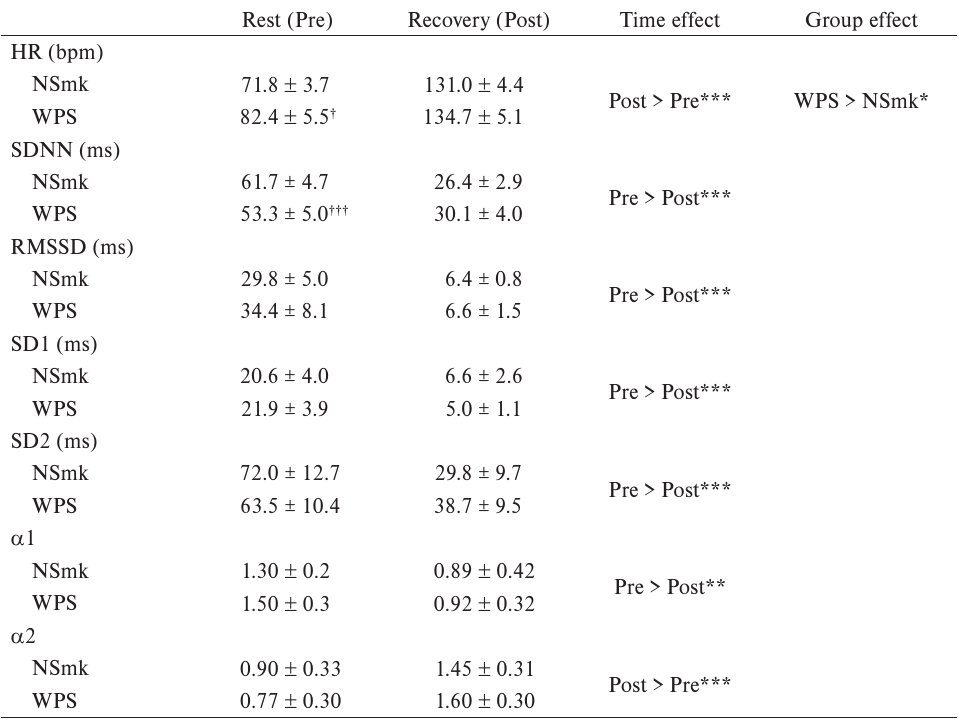
Mean (± SD) heart rate variability measures prior to (Pre) and following (Post) Wingate test for non-smoker (NSmk) and waterpipe (WPS)